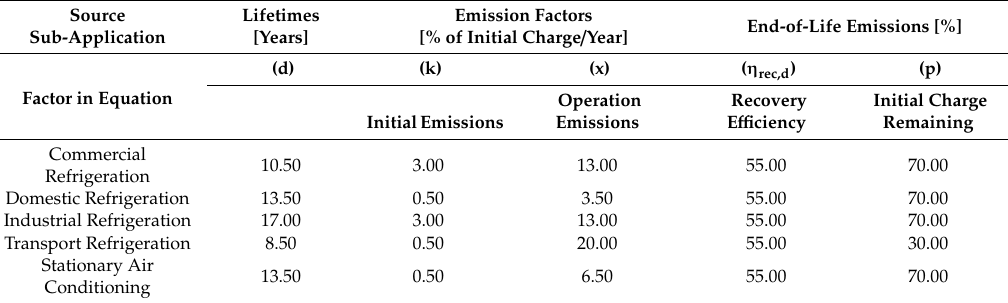
Table 3. Emission factors used for emission estimates in 2018.